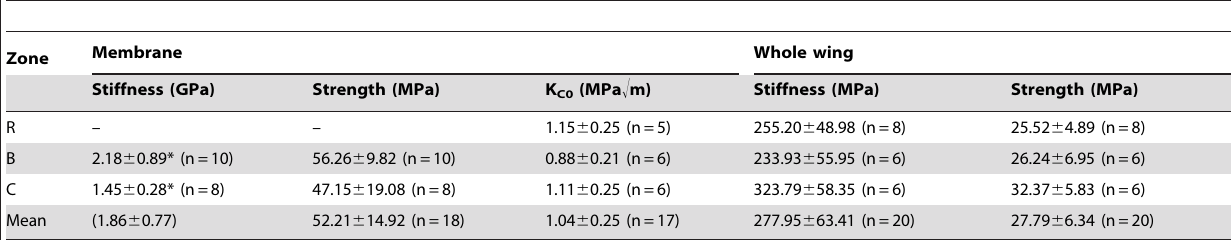
Table 2. Summary of stiffness, strength and fracture toughness from fresh isolated wing membrane sections and complete wing sections (membrane plus veins) from three different regions of the hind wing (see Figure 1 a).